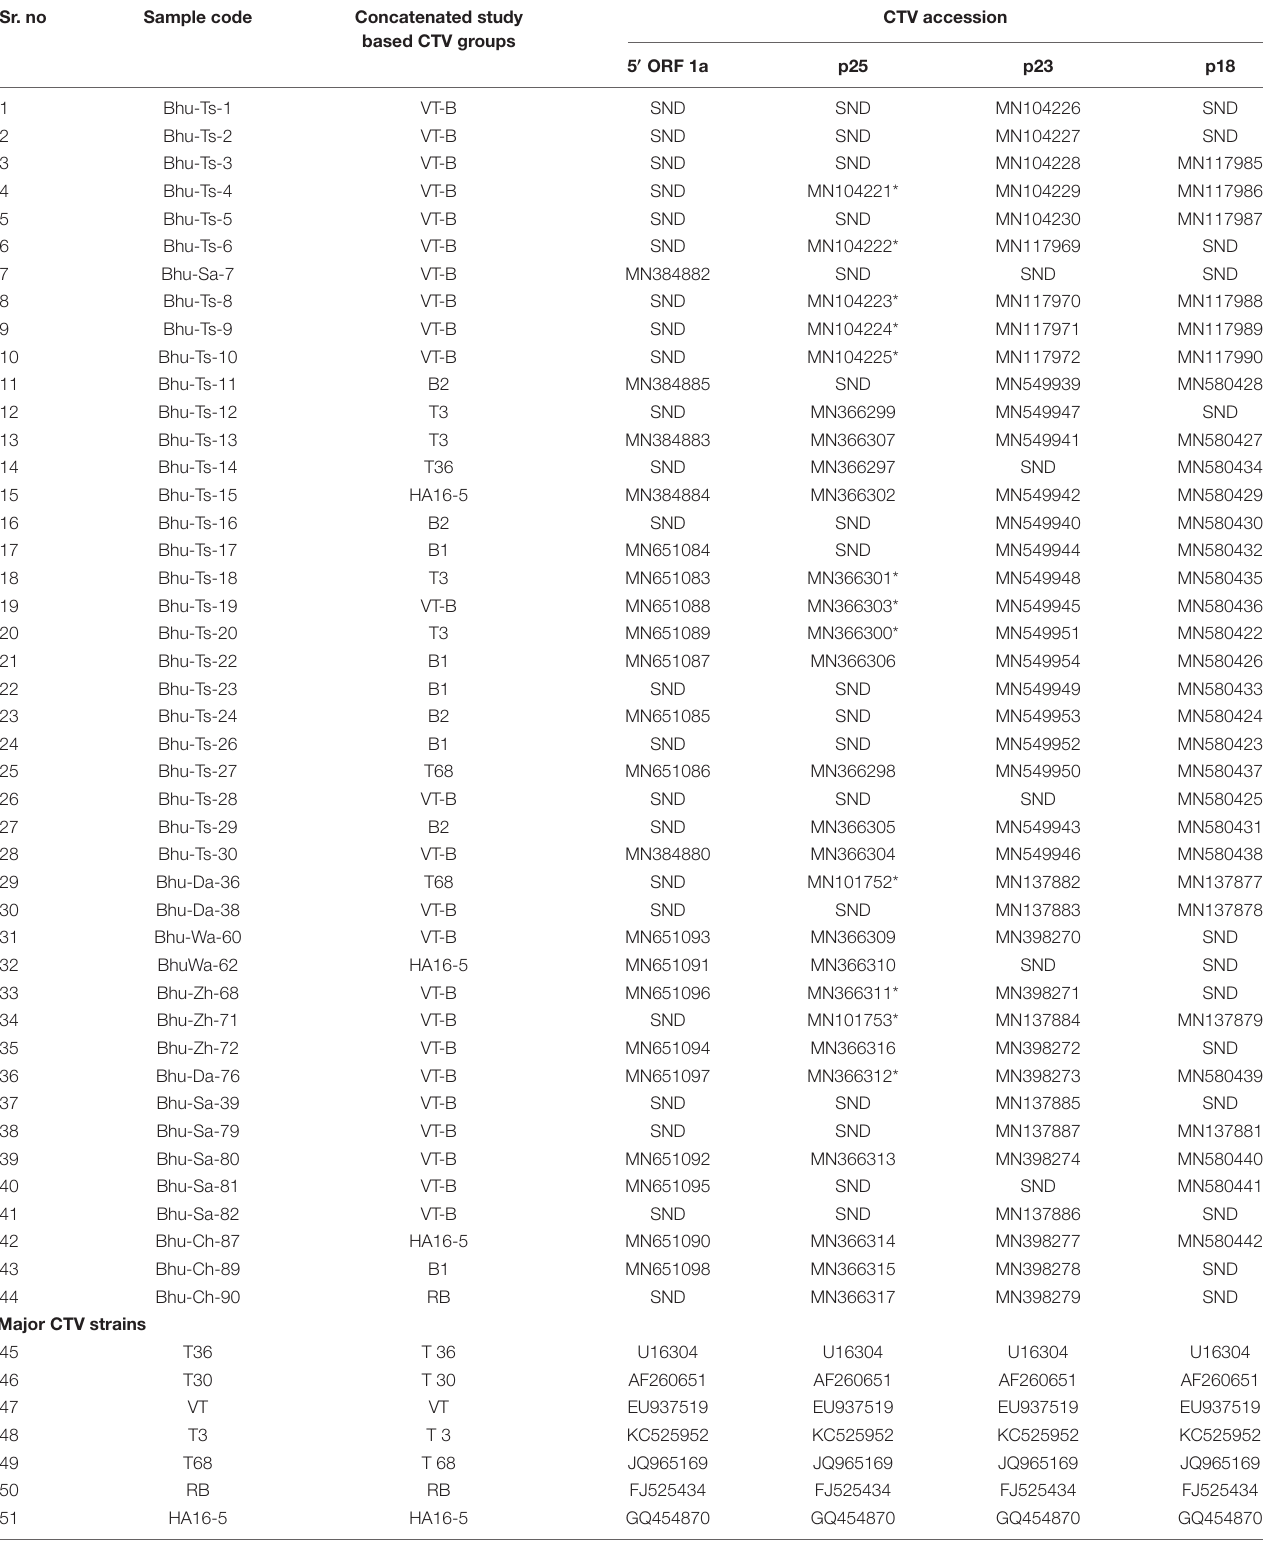
TABLE 3 | Citrus tristeza virus (CTV) isolates collected from different geographic regions of Bhutan. Four different specific genomic regions are sequenced and their accession numbers are presented. Sr.